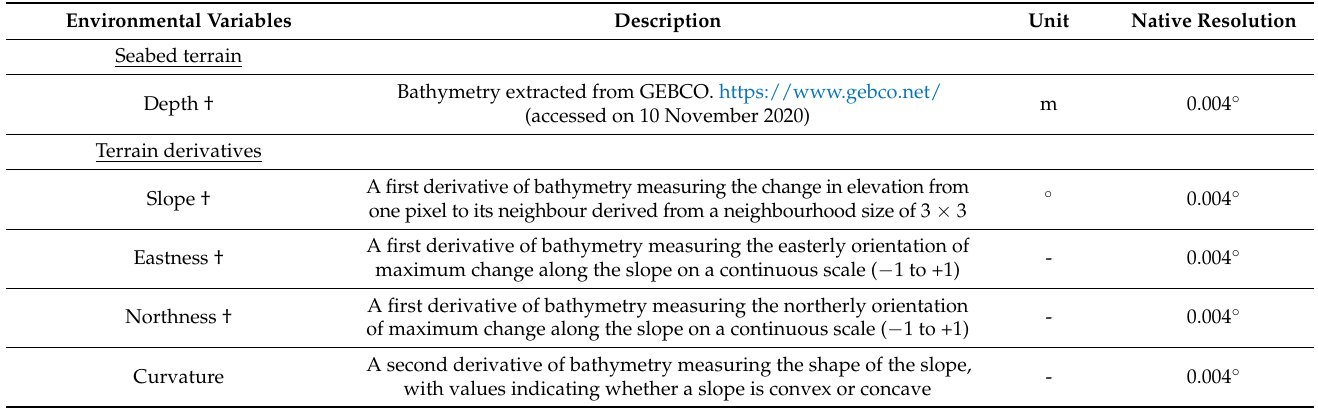
Table 1. Environmental variables used in modelling. † Environmental variable retained in final